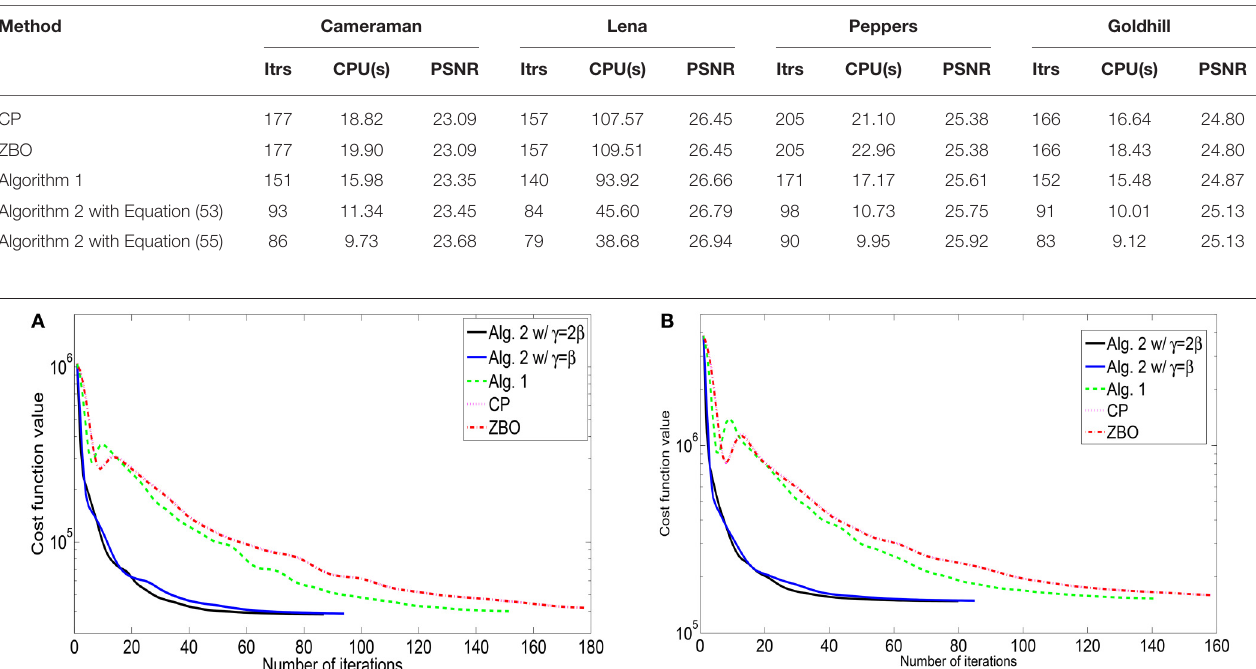
FIGURE 1 | Evolutions of function values of the L2-TV model for images of (A) “Cameraman” and (B) “Lena.”